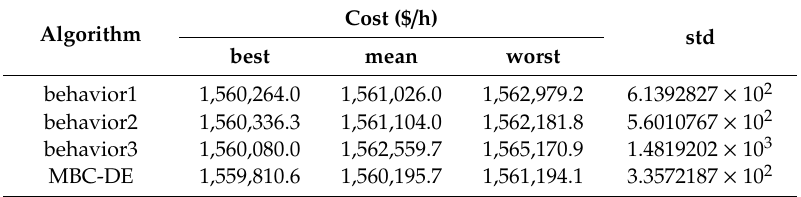
Table 15. Algorithms comparison between multi-behavior and single-behavior for test case 4.